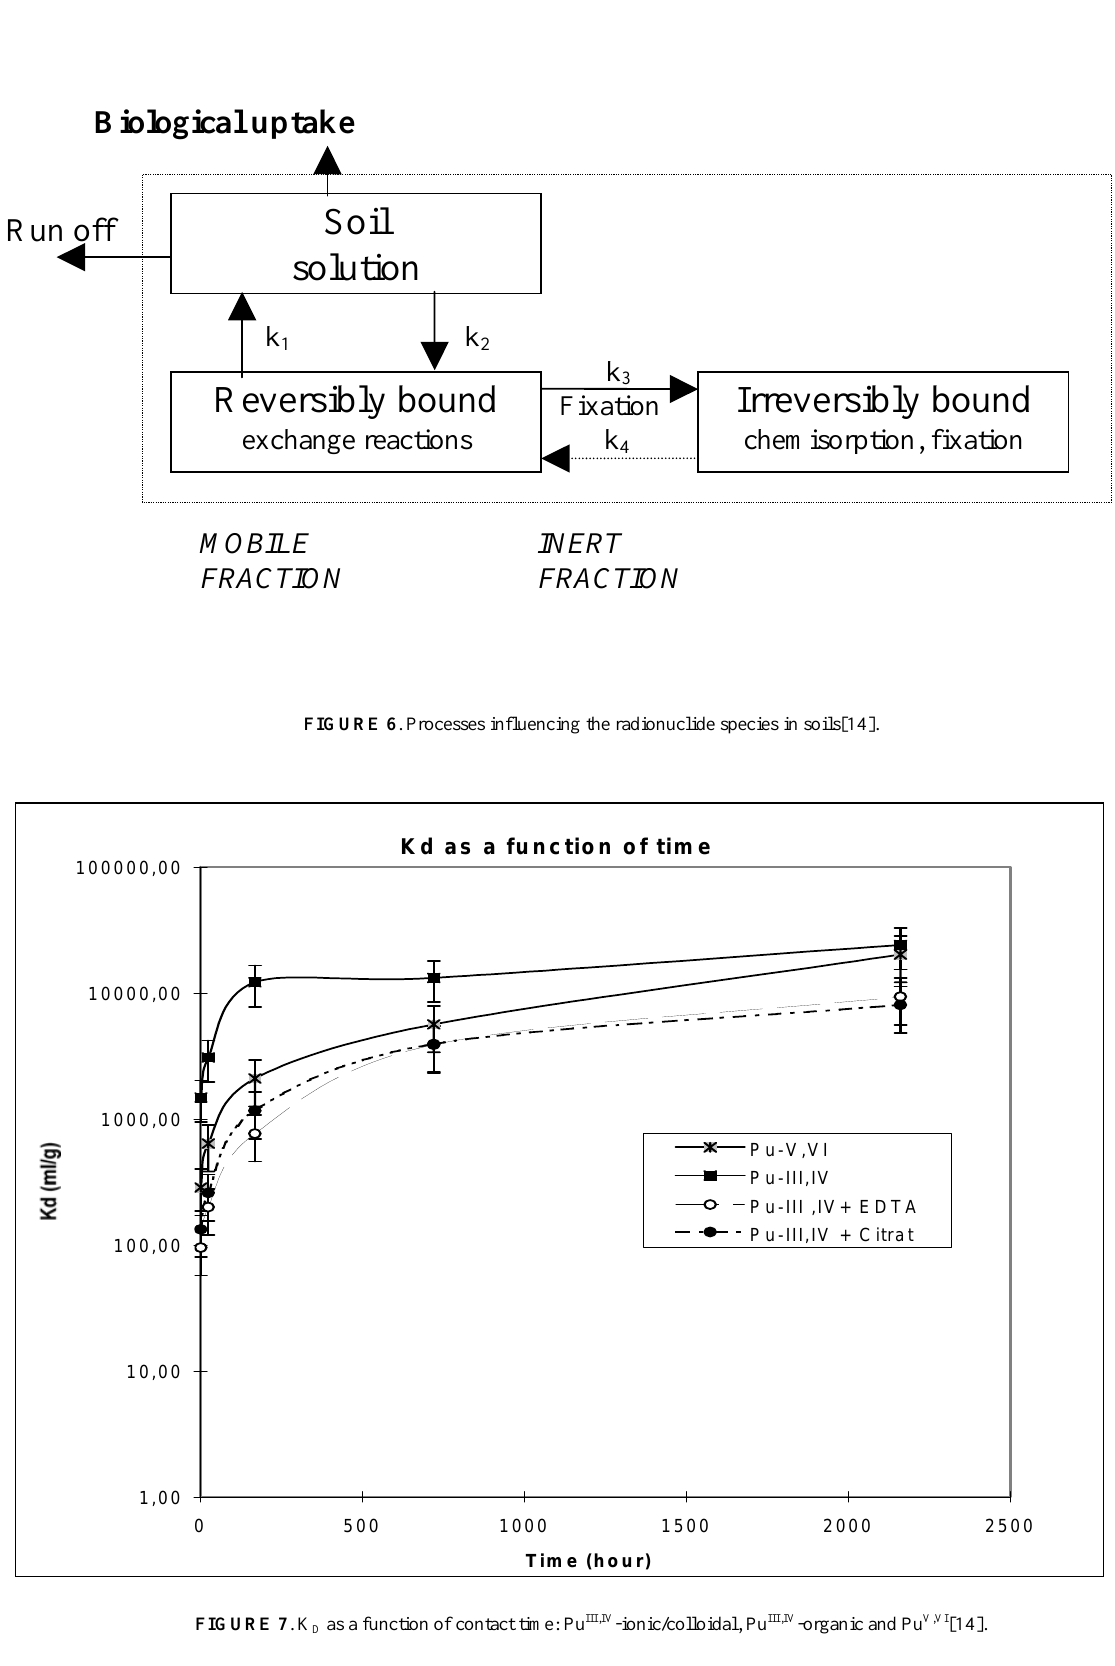
FIGURE 7 . K D as a function of contact time: Pu III,IV -ionic/colloidal, Pu III,IV -organic and Pu V,VI